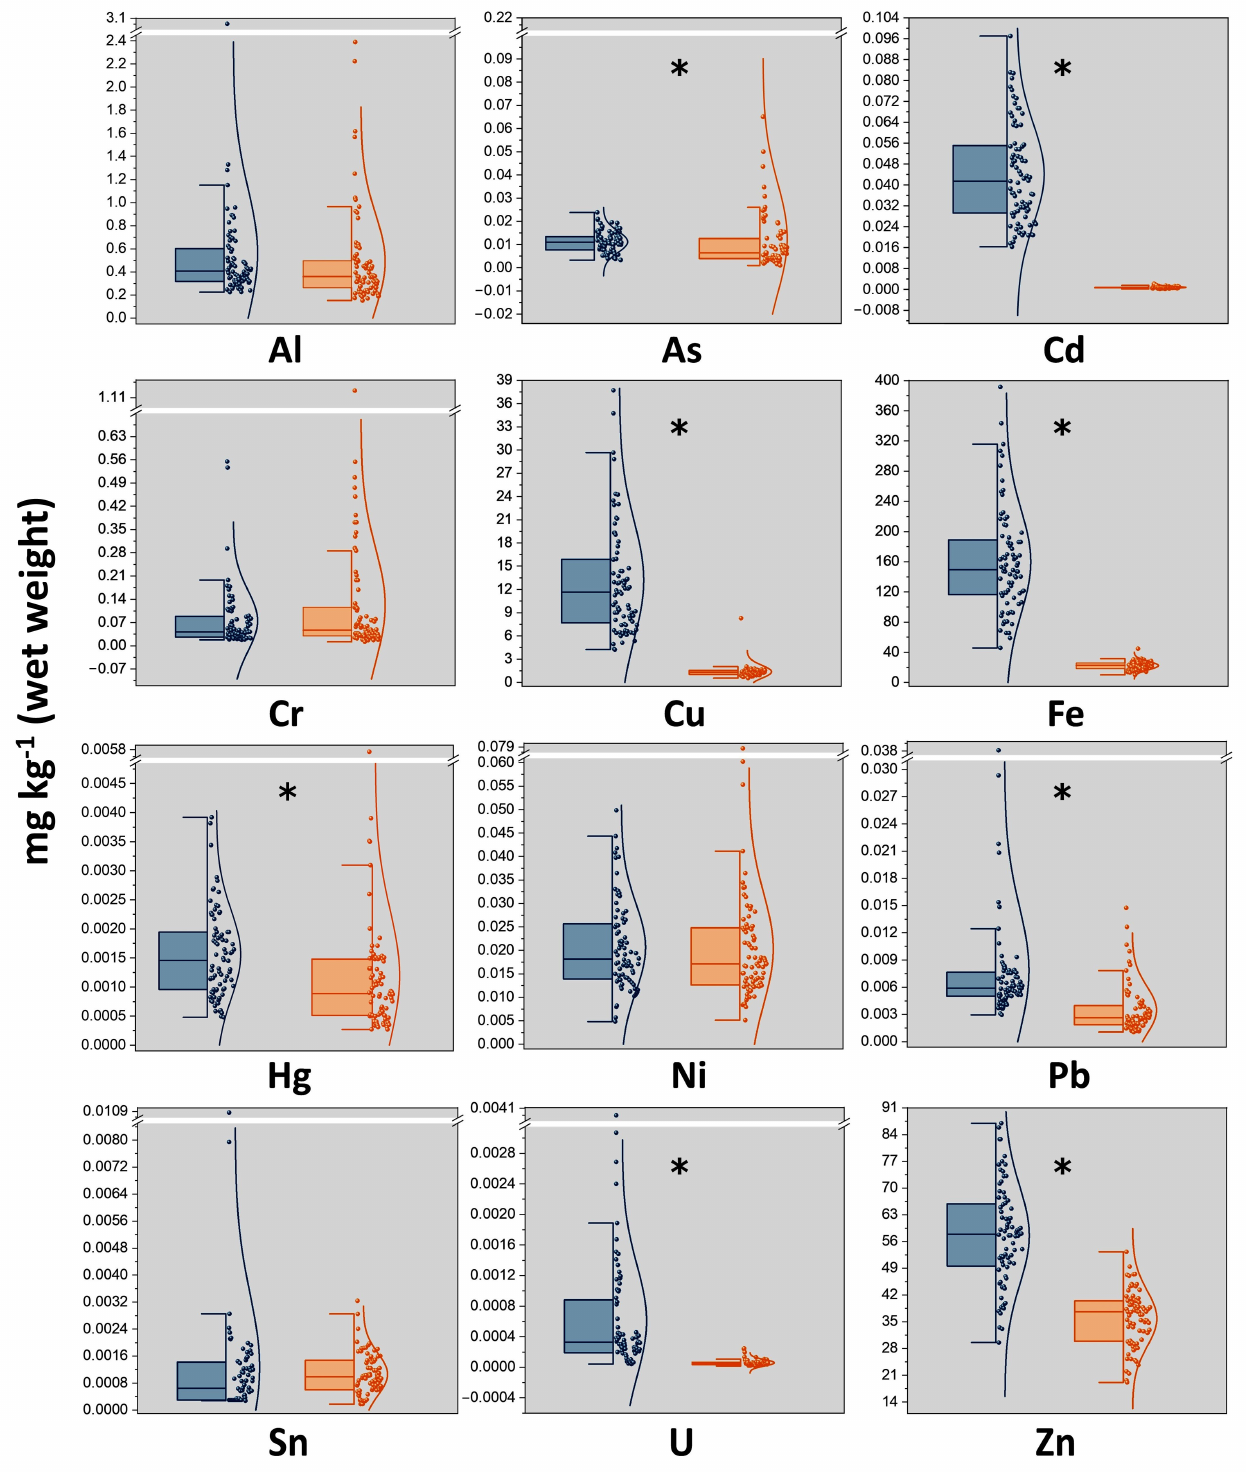
Figure 1. Half-box/violin plots showing concentrations (upper-bound, UB, wet weight) and size distributions of TMMs in pig liver (blue) and muscle (orange) samples. Boxes: lower 25% quartile, median, and upper 75% quartile; whiskers: ± 2 times the interquartile range; statistically significant differences between muscle and liver according to Mann–Whitney U test: * ( p ≤ 0.01).